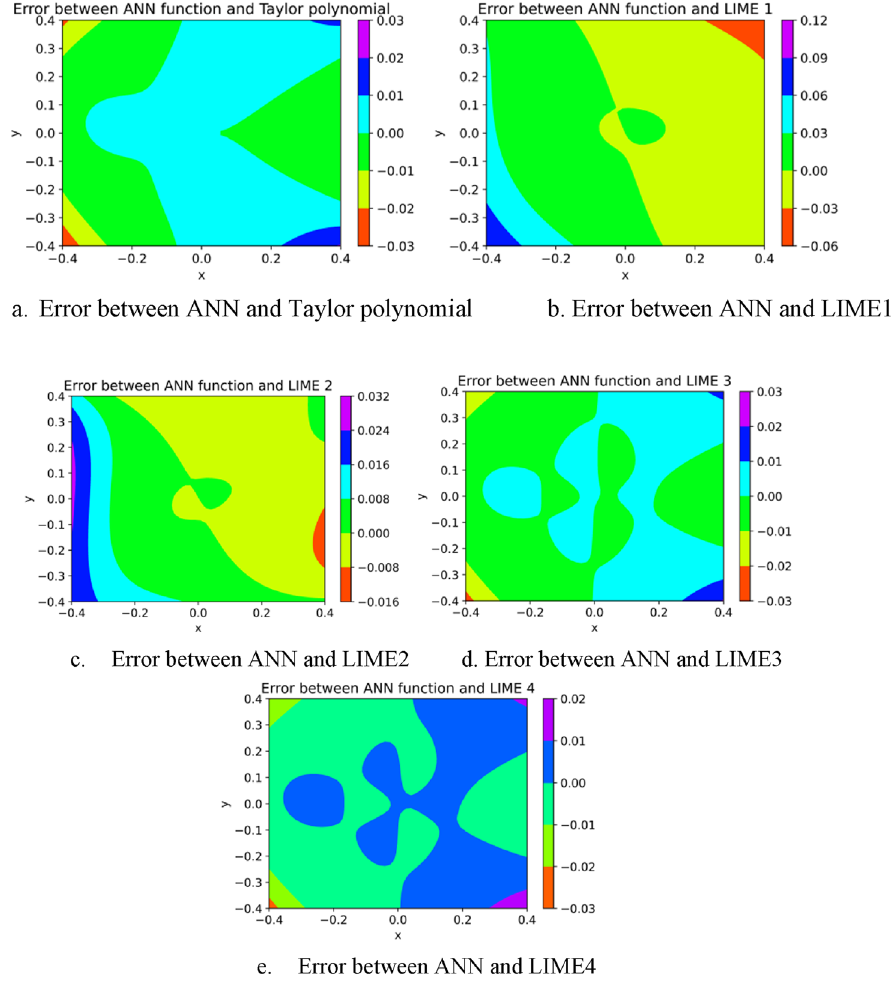
Fig. 11 Error profile of LIME models and current methodology